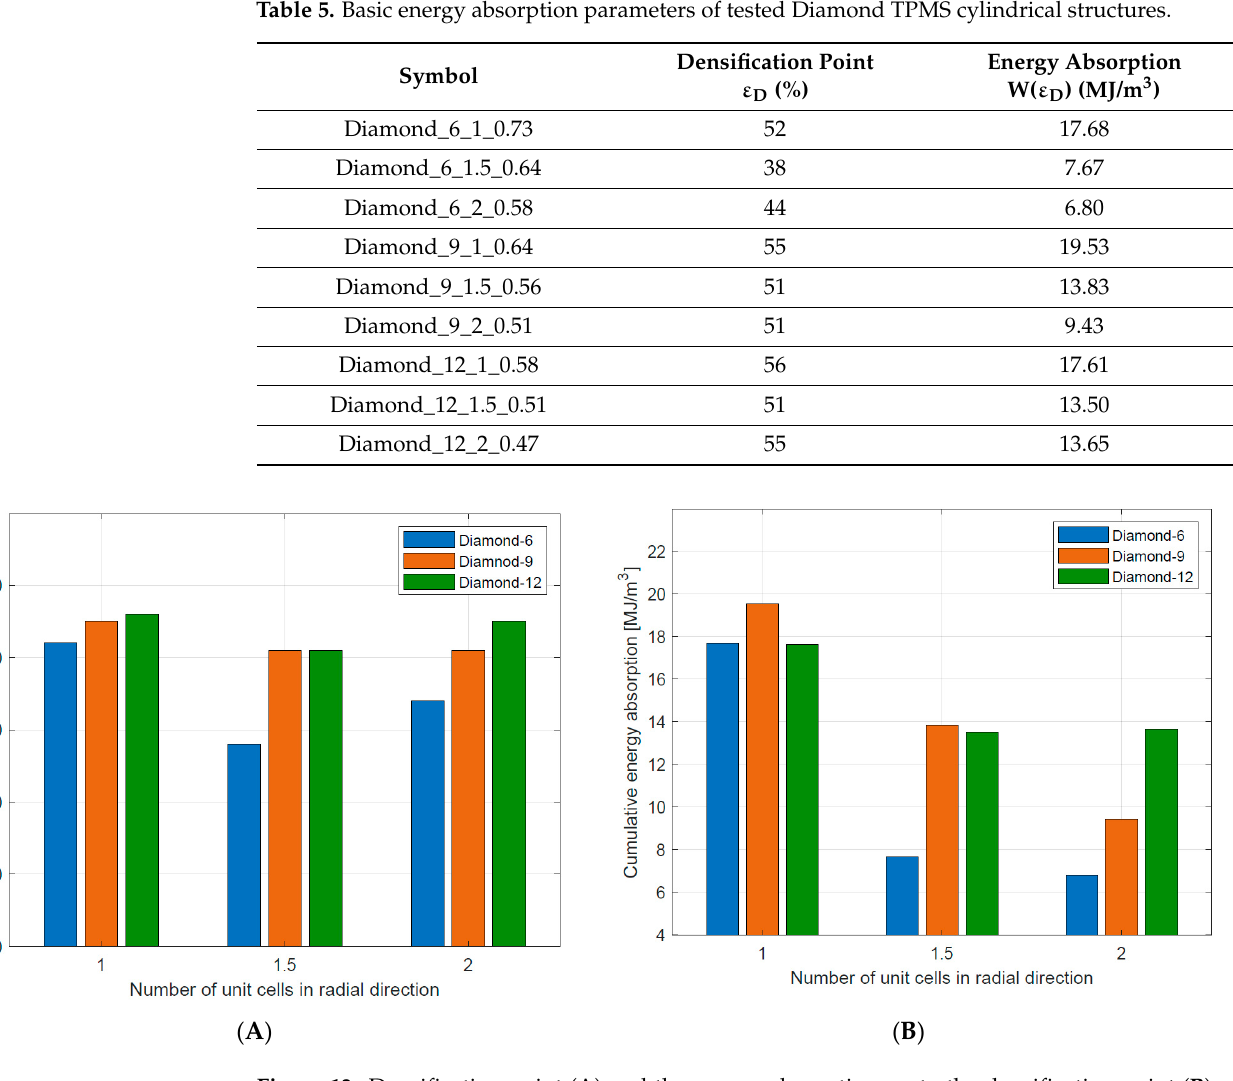
Figure 13. Densification point ( A ) and the energy absorption up to the densification point ( B ) of tested Diamond TPMS cylindrical structures.